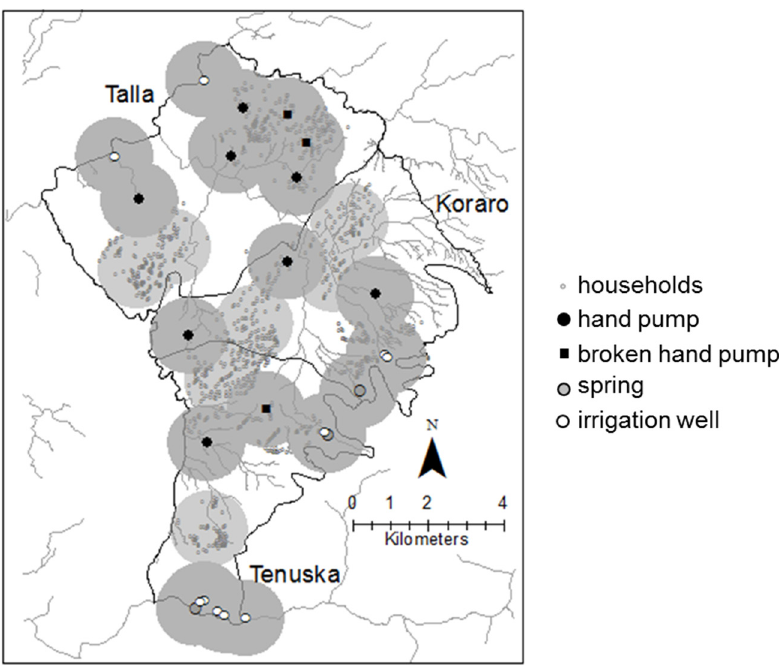
Figure 8. Well Field with well placement to satisfy the criteria of households being 1000 m of a water source (additional wells depicted by the light grey buffer).